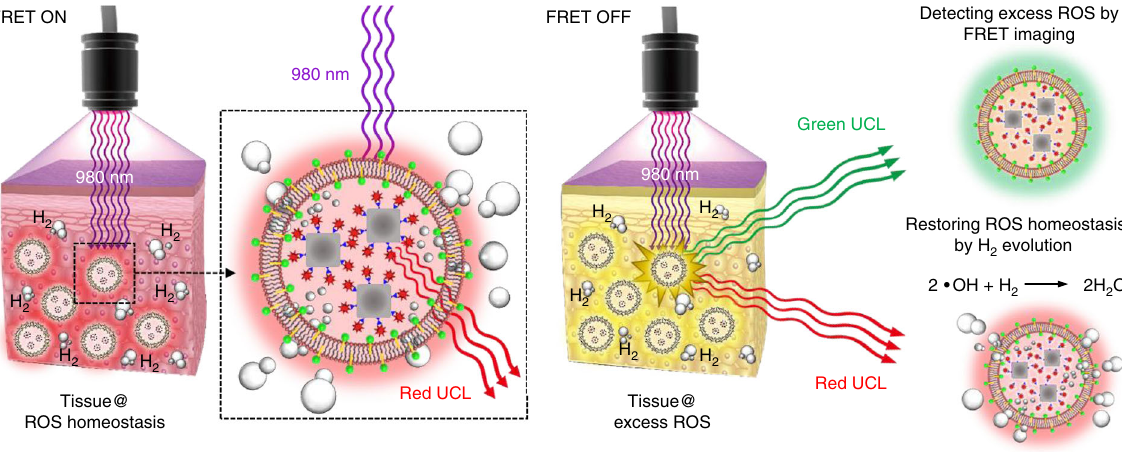
Fig. 1 Composition/structure of Lip NP and its operating mechanism. In as-proposed Lip NP, whose aqueous core encapsulates Cit-UCNP-TK-AuNPs nanocomplexes and in which the lipid bilayer embeds chlorophyll a (Chl a ). NIR laser penetrates biological tissue and is converted to green and red UCL by Cit-UCNP in nanocomplex. Green UCL is used to measure local ROS concentration for FRET imaging, and red UCL induces photosynthesis of gaseous H 2 to scavenge excess